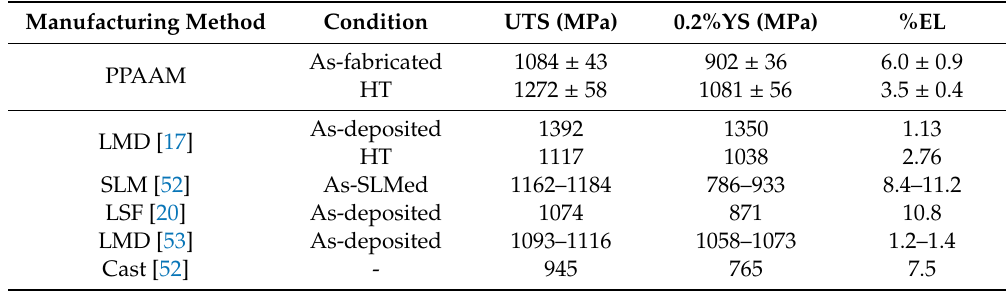
Table 5. Tensile properties of the IN738LC components fabricated by PPAAM vs. other manufacturing